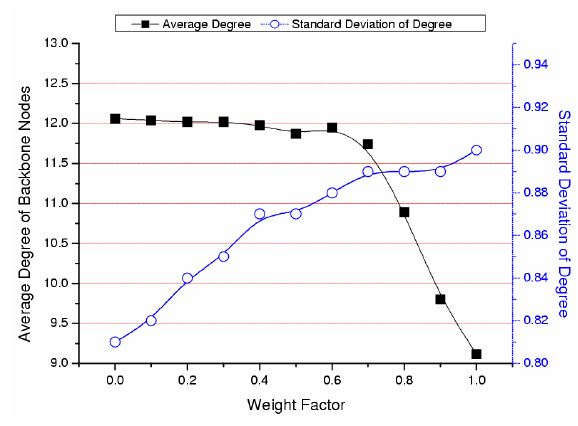
Figure 4. Average and standard deviation of degree.